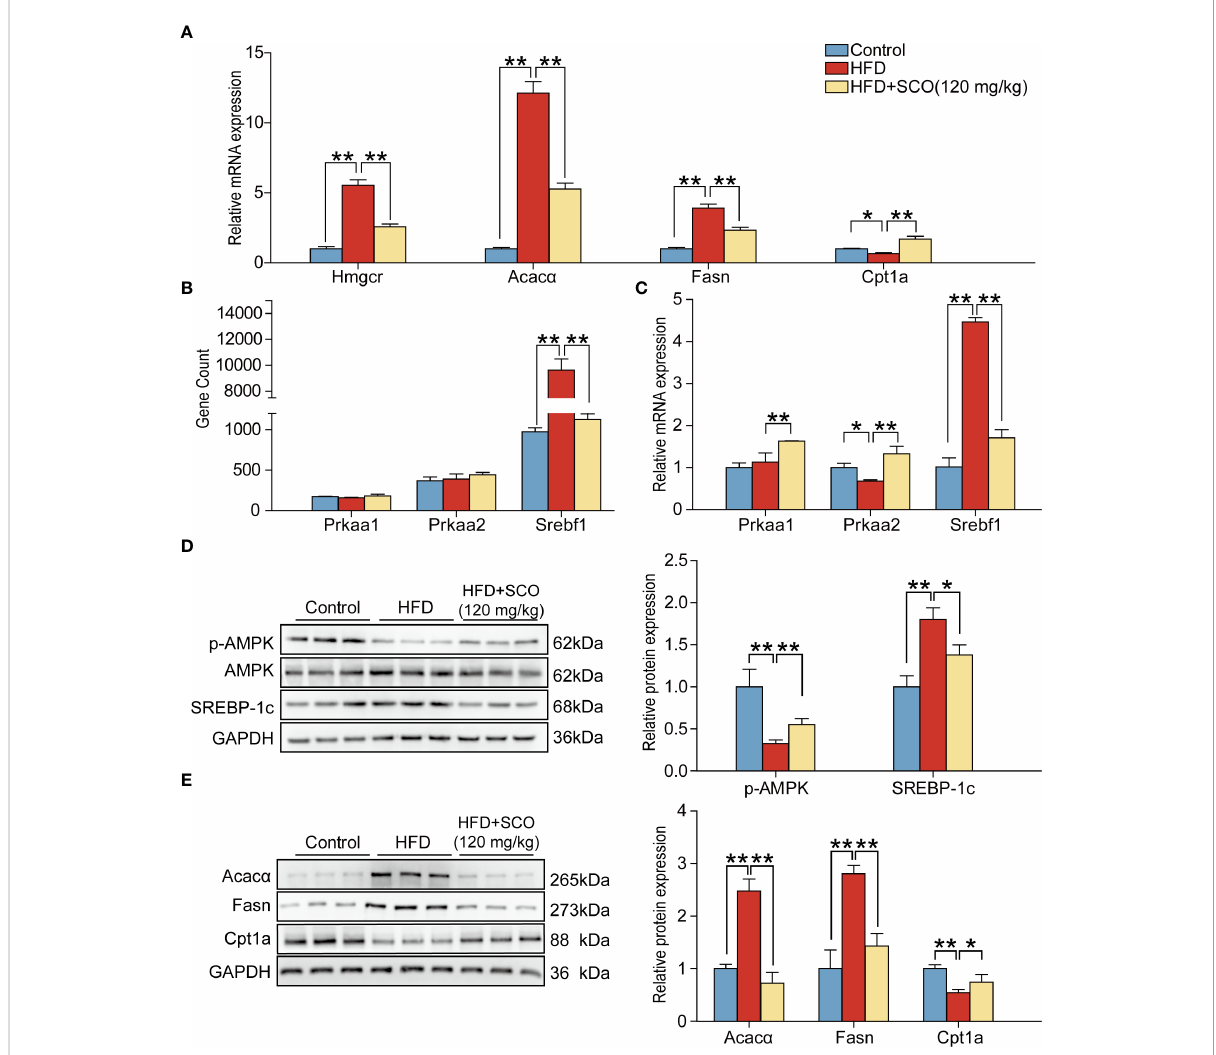
FIGURE 7 The results of validation experiments detected by qRT-PCR and western blot. (A) Relative mRNA expressions of Hmgcr, Fasn, Acac a and Cpt1a in mice liver tissue. (B) The gene expressions of Prkaa1, Prkaa2 and Srebf1. (C) : Relative mRNA expressions of Prkaa1, Prkaa2, Srebf1. (D, E) : The protein expressions of p-AMPK, SREBP-1c, Fasn, Acac a and Cpt1a. The relative expressions of protein were normalized against the control group, with GAPDH as the internal reference. All data are presented as the mean ± SD (n = 3). * P < 0.05, ** P <